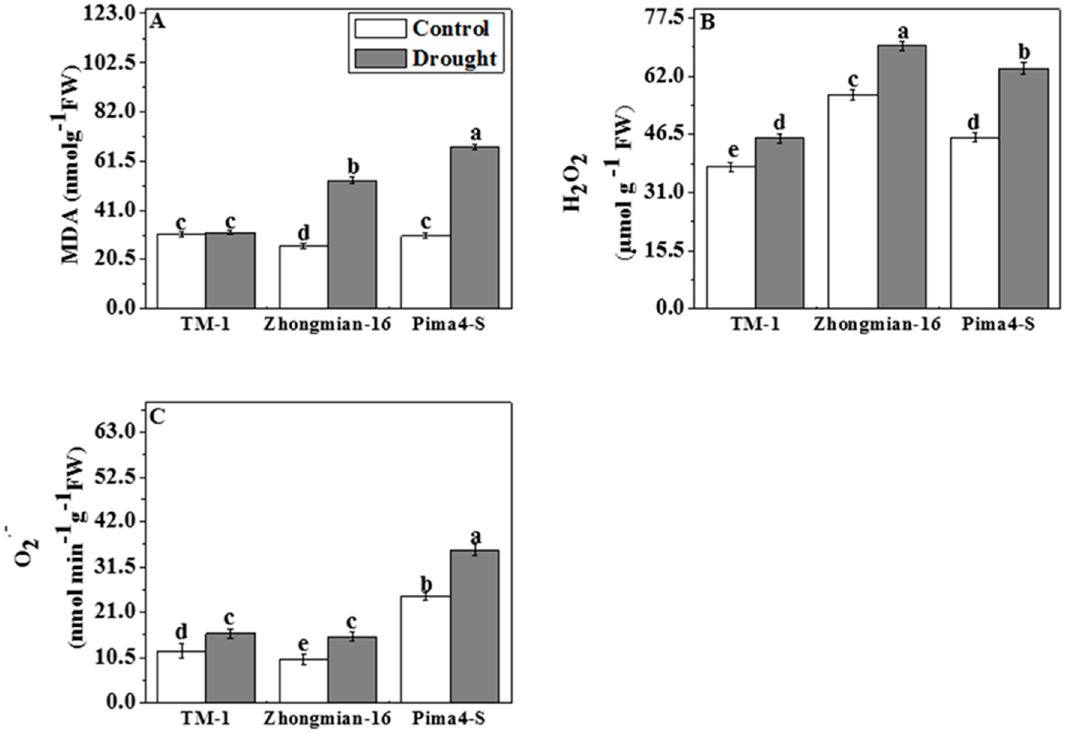
Figure 6. Effects of drought on malondialdehyde (MDA, A ); hydrogen peroxide (H 2 O 2 , B ) and superoxide radical (O 2 , C ) contents in leaves of three cotton species. Means denoted by the same letter are not significantly different at p < 0.05. Error bars are ±SD ( n = 4).